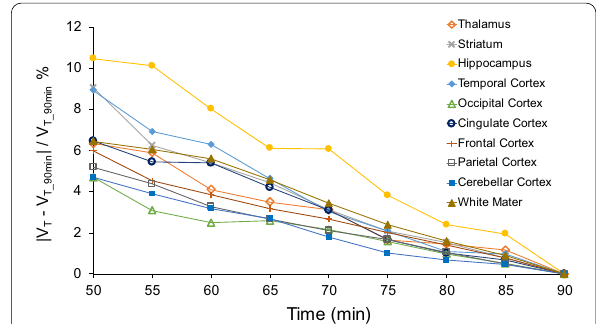
Fig. 5 Assessment of the relative stability in 11 C-CPPC total distribution volume ( V T ) values from 90 min of data compared to values produced from truncated scan durations. Ninety-min emission data from eight healthy individuals were shortened in five min intervals down to a minimum 50-min scan duration. Regional V T values are in units of mL cm − 3 . The percent absolute difference between the V T values from 90 min of data and V T values from shortened scan duration is plotted for each of the ten brain regions of